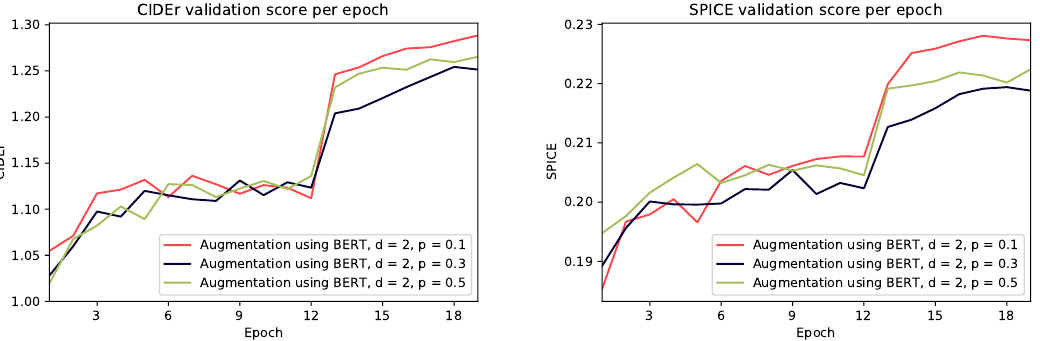
Figure 1. Validation scores per epochs during a training phase on a datasets with Bidirectional Encoder Representations from Transformers (BERT) augmentation with d = 1 and p = 0.1,0.3,0.6.